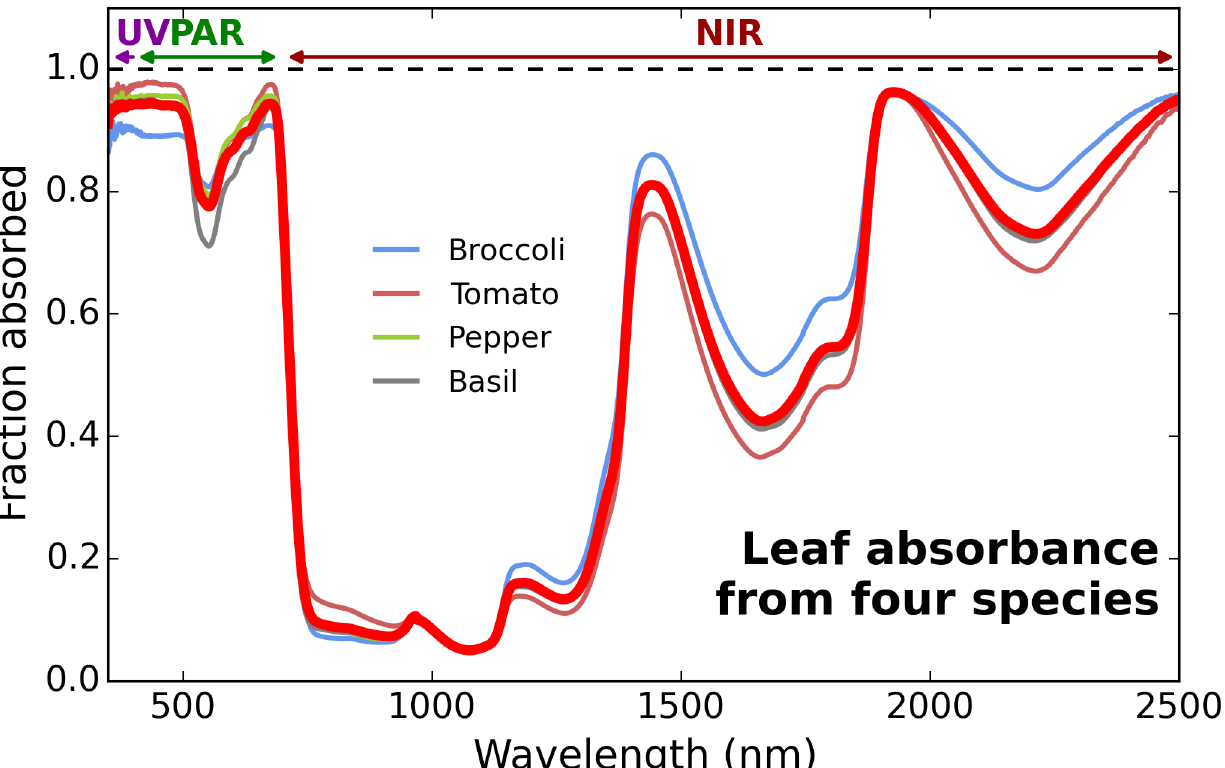
Fig 1. Average absorption (red line) of leaves from tomato, pepper, basil and broccoli. Variation among species is due to differences in leaf reflectance. The broccoli leaf had slightly higher reflectance of PAR than the other species. All plants were grown in a greenhouse.